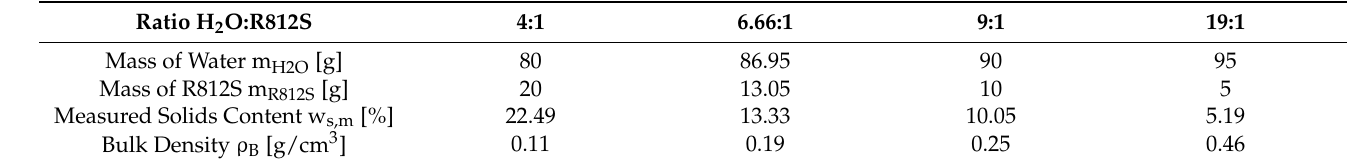
Table 1. Summary of dry water mixing ratios, associated masses and bulk density.